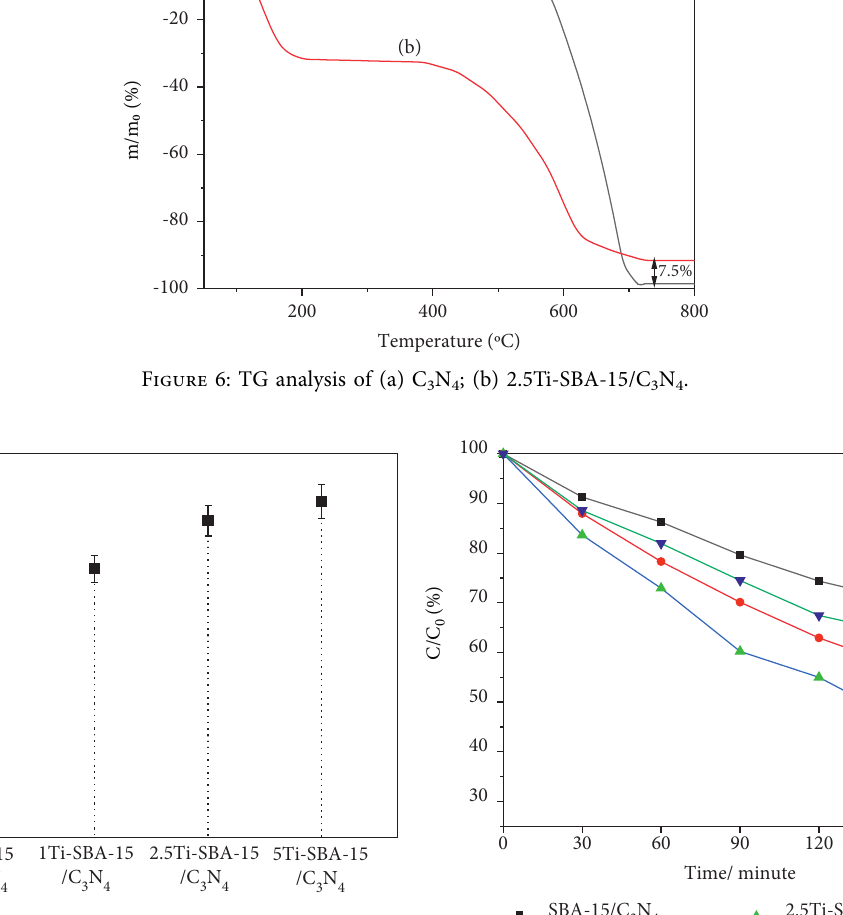
Figure 7: Effects of various amounts of Titanium for 2,4-D removal: (a) light off; (b) light